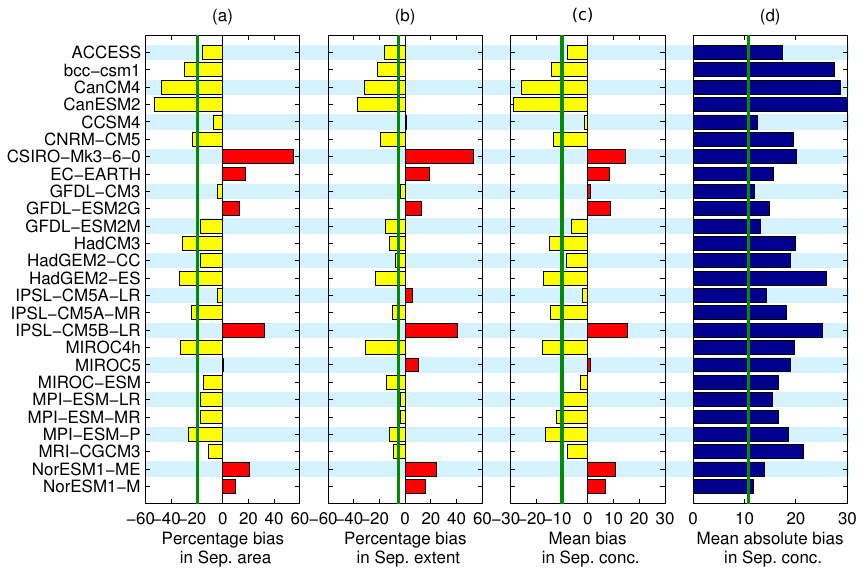
Fig. 11. Overview of biases in September sea-ice coverage in the 117 “historical” CMIP5 simulations analysed for this study relative to Bootstrap satellite retrievals. (a) Mean bias in September sea-ice area. (b) Mean bias in September sea-ice extent. (c) Mean bias in sea-ice concentration. (d) Mean absolute bias in sea-ice concentration. The vertical green lines denote the respective bias of the NASA Team retrieval relative to the Bootstrap